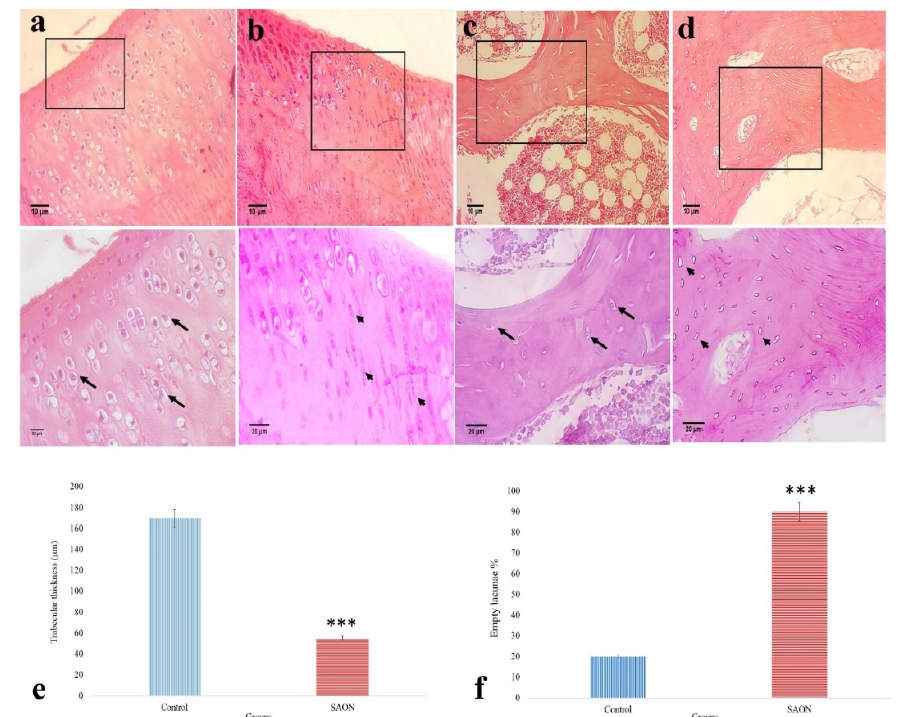
Figure 6. Histological confirmation of SAON induction in the rabbit. Articular cartilage cell mor- phology in ( a ) control and ( b ) SAON group. Subchondral bone in ( c ) control and ( d ) SAON group. Arrows and arrowheads indicate healthy and damaged cartilage cells as well as bone lacunae con- taining osteocytes in articular cartilage and subchondral bone, respectively. ( e , f ) The trabecular bone thickness ( μ m) and the empty lacuna in the control and SAON group. Data are shown as mean ± SD. *** p < 0.001 compared to control.